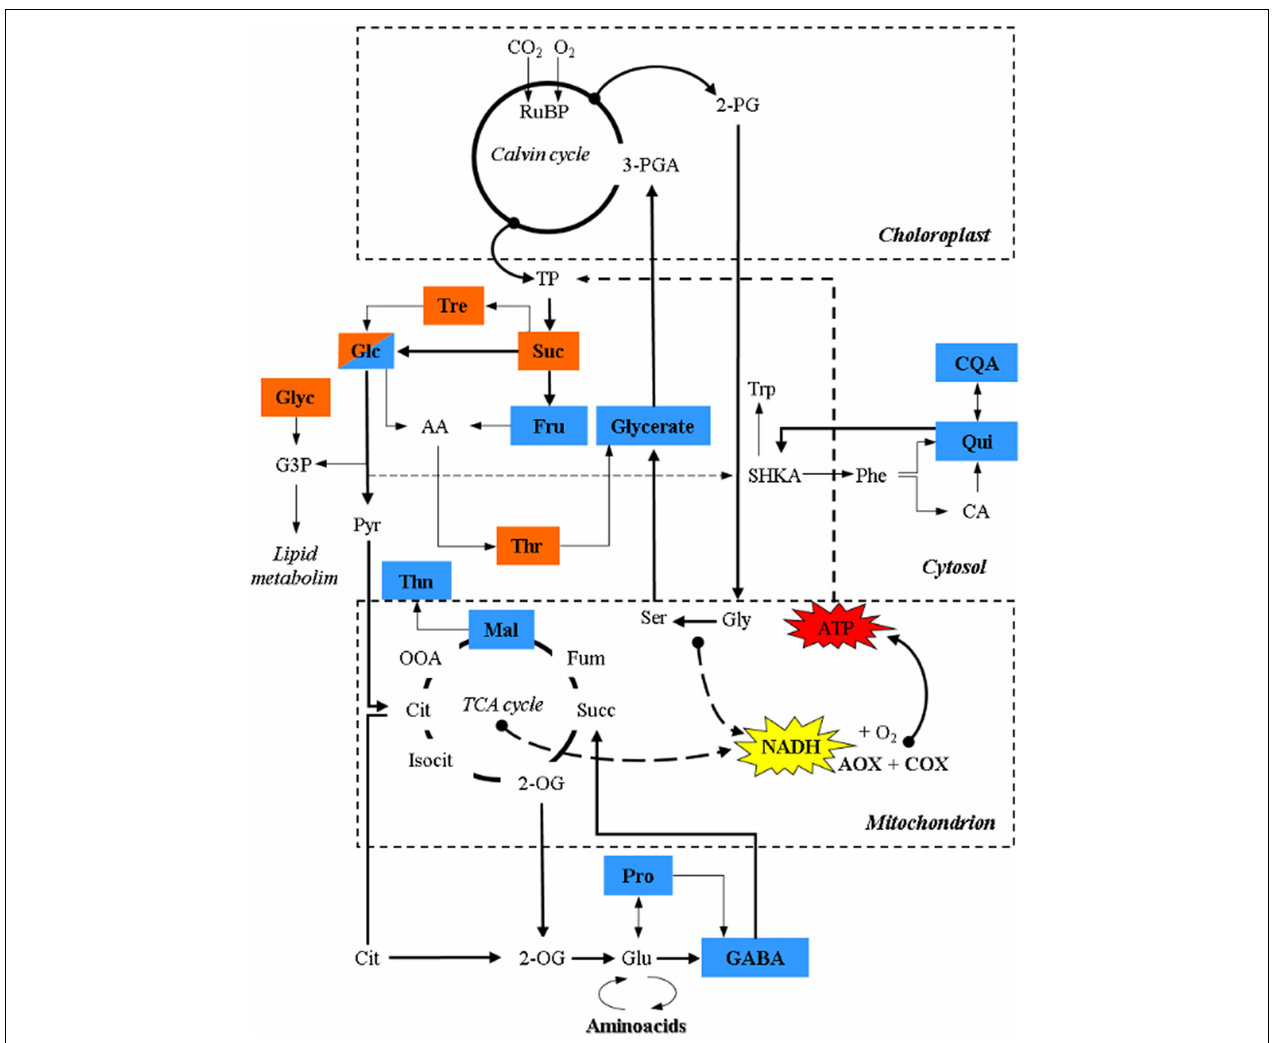
FIGURE 4 | Schematic representation of the TCA cycle and its connection with metabolites, related to sugar metabolism, photorespiration and secondary metabolism, showing significant relationships with τ a identified with a PLS approach through multivariate regression modeling. Brown and blue colors denote significant relationships with τ a in terrestrial and palustrine environments, respectively. 2-PG, 2-Phosphoglycolate; 3-PGA, 3-Phosphoglyceric acid; RuBP, RuBisCO; TP, triose phosphate; Suc, sucrose; Tre, Trehalose; Glc, Glucose; AA, Ascorbic acid; Fru, fructose; Thr, threonic acid; Gly, glycine; Glyc, glycerol; G3P, glycerol 3-phosphate; SHKA, shikimate; Trp, tryptophan; Phe, phenylalanine; CA, caffeic acid; Qui, quinic acid; CQA, caffeoylquinic acid; Pyr, pyruvate; Cit, citrate; OOA, oxaloacetate; Mal, malate; Thn, threonine; Fum, fumarate; Suc, succinate; 2-OG, 2-oxoglutarate; Pro, proline; GABA, γ -aminobutyric acid; Glu,